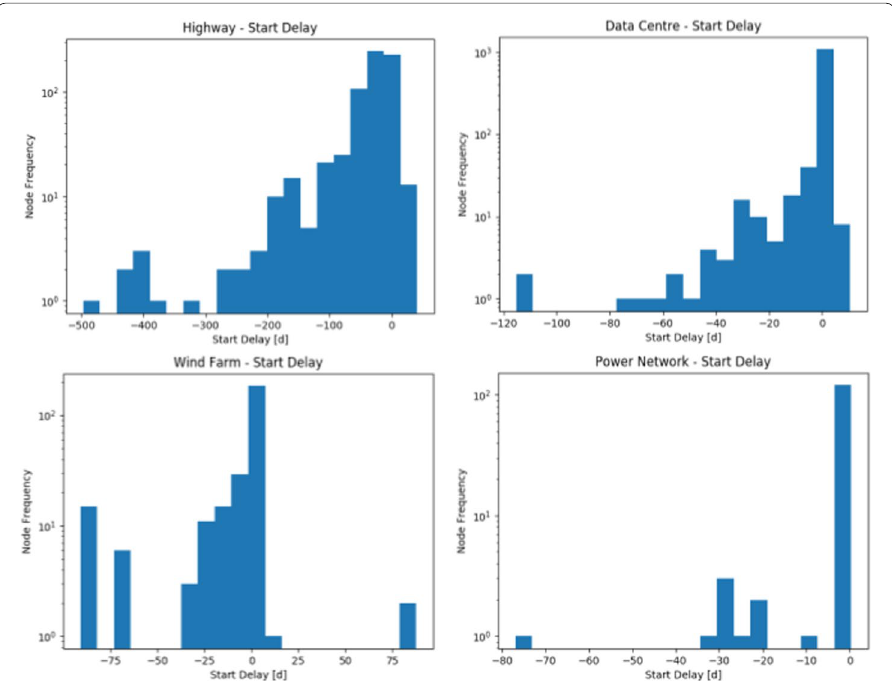
Fig. 2 Frequency distribution of Start Delay (in days) for different activities. All distributions are starkly peaked around zero, with values close to the peak surpassing their further counterparts by orders of magnitude (hence the need for the logarithmic scale). HW and DC show a left tail, and WF is the only dataset recording delays larger than a few